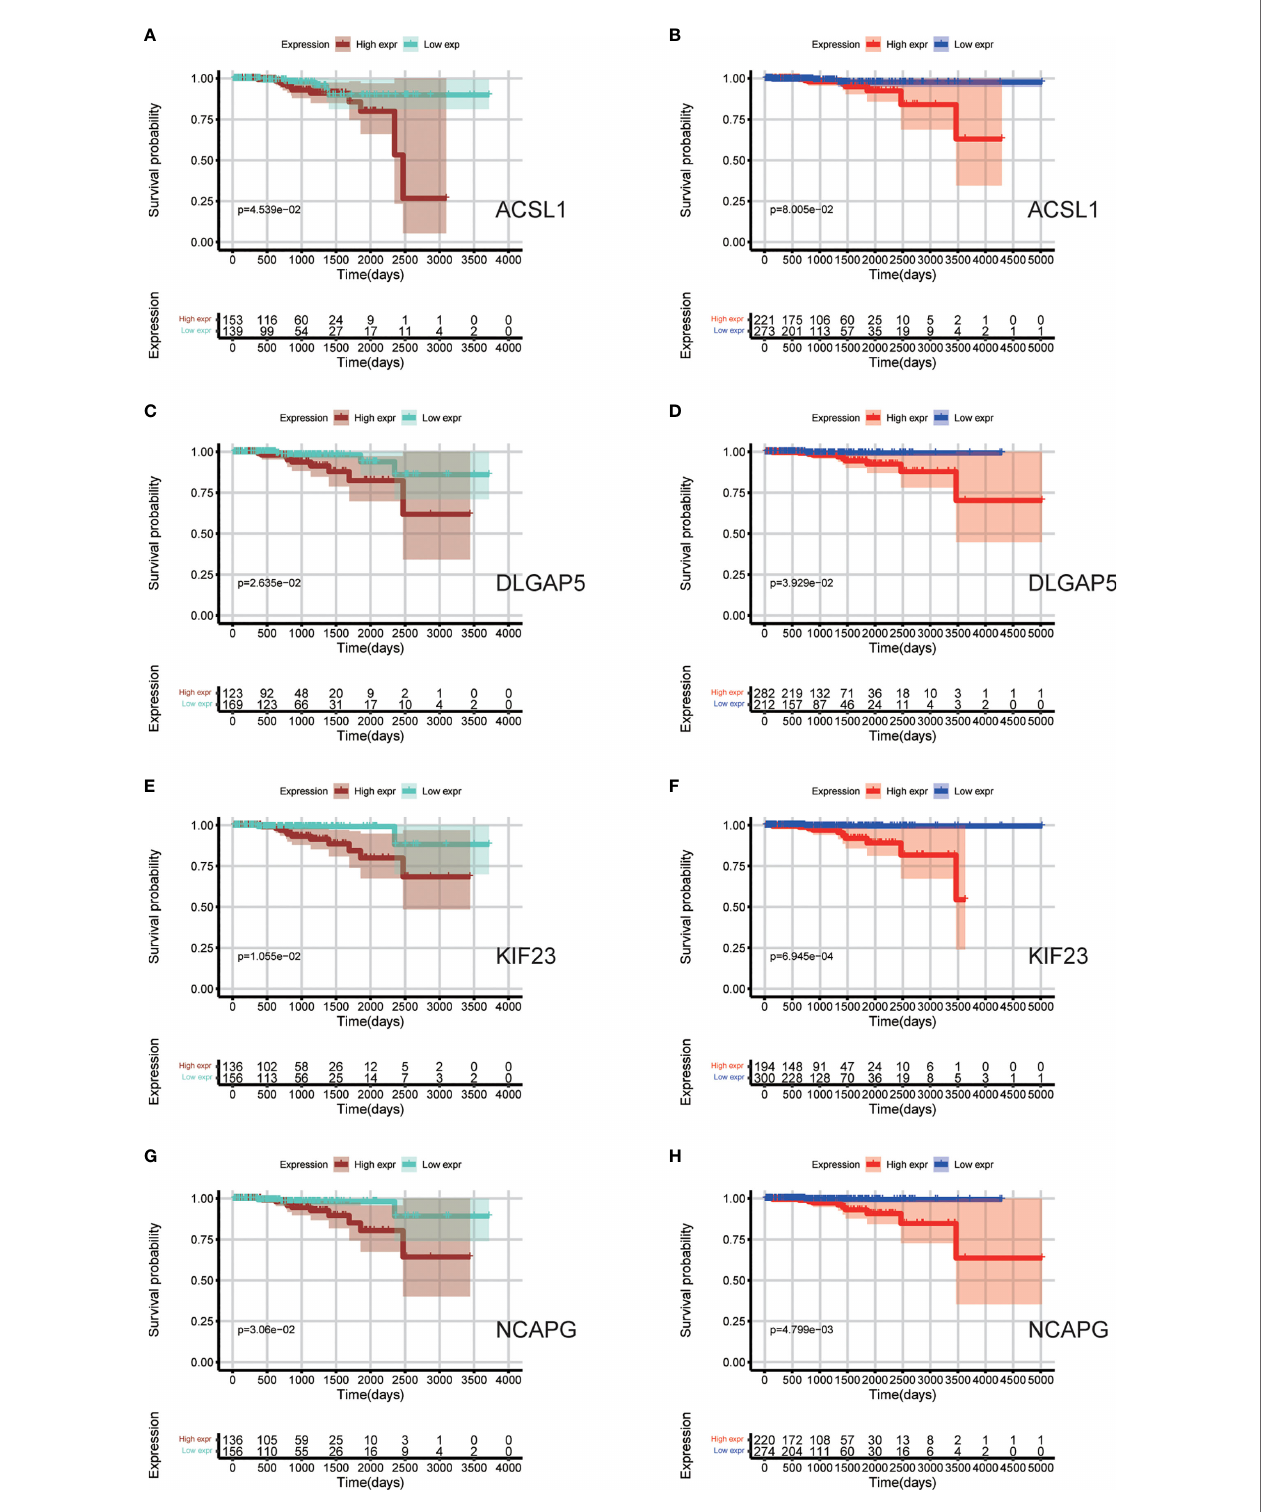
FIGURE 7 | Survival analyses based on TCGA and ICGC cohorts to evaluate value of hub genes as prognosis biomarkers. (A , C , E , G) Overall survival between patients with high and low expression of the four hub genes based on TCGA cohorts; (B , D , F , H) Overall survival between patients with high and low expression of the four hub genes based on ICGC